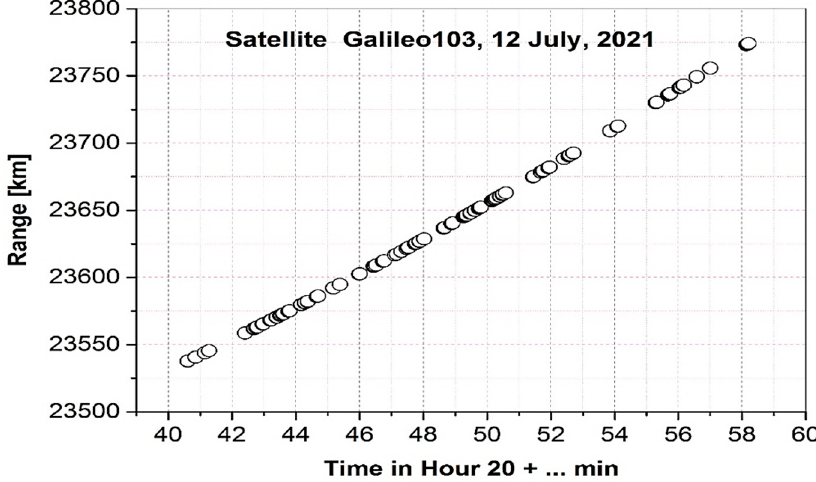
Figure 3. The range of the satellite Galileo 103 observed on 12 July 2021.